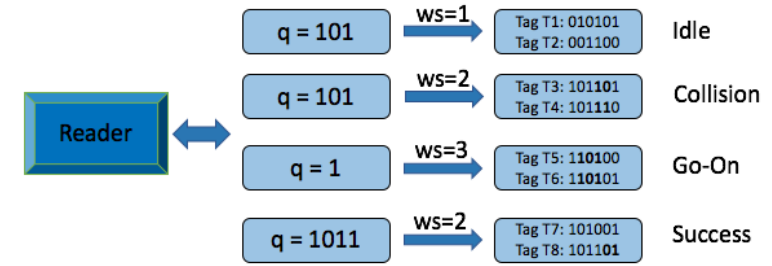
Figure 15. Window synchronized answer.